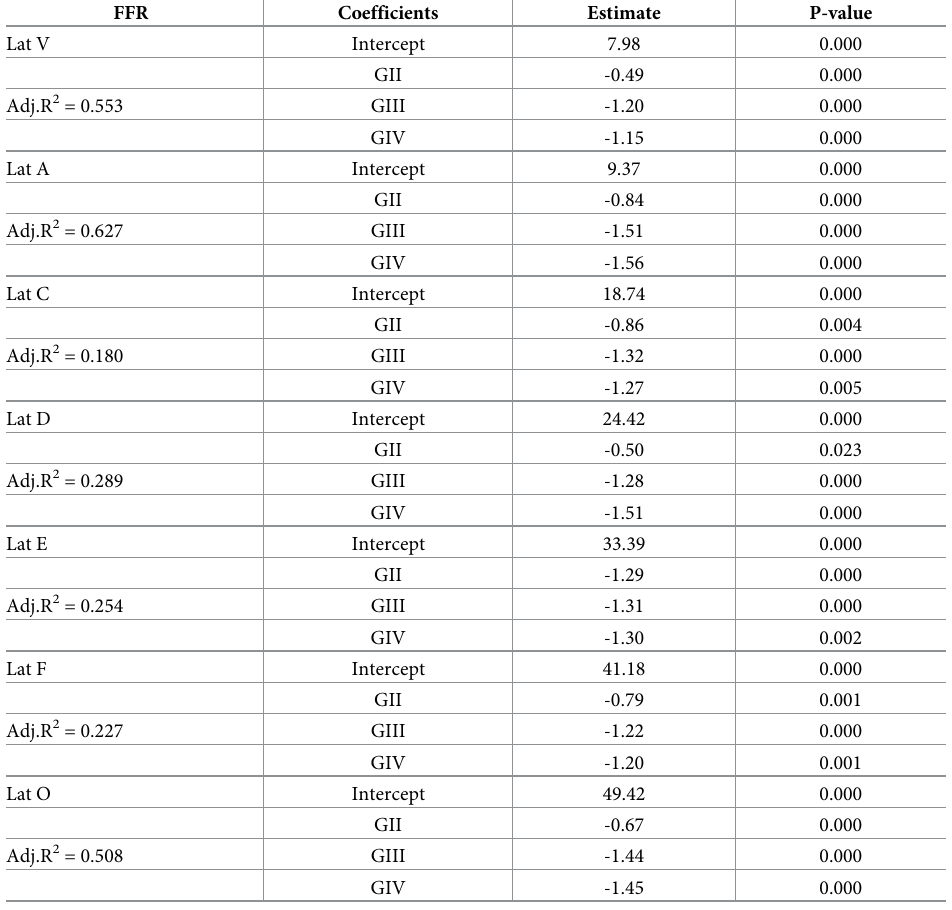
Lat = Latency; GI = newborns; GII = infants; GIII = preschool children; GIV = school aged children; Adj. R 2 = model adjusted coefficient of